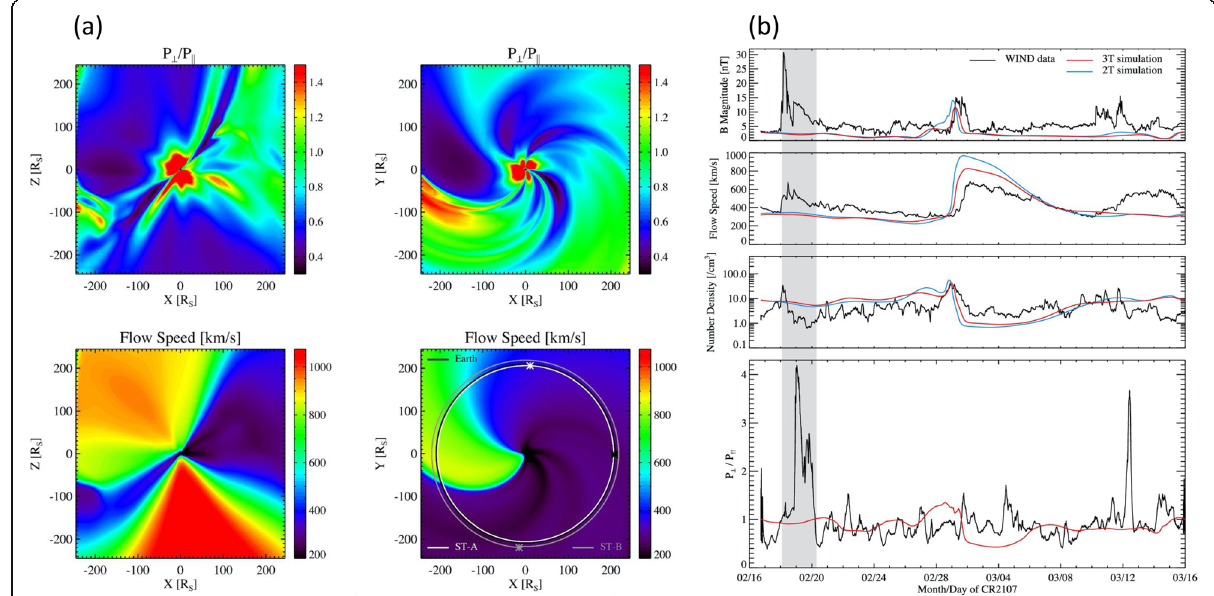
Fig. 12 a The simulated proton pressure anisotropy ratio p ⊥ /p_ and the simulated solar wind speed in the Y = 0 and Z = 0 planes for CR2107 by the AWSoM model, and the plot on the right bottom panel also shows the trajectories of the Earth, STEREO-A and B satellites projected to the Z = 0 plane; b The simulated solar wind properties along the WIND orbit and the WIND data during CR2107 (From Meng et al.